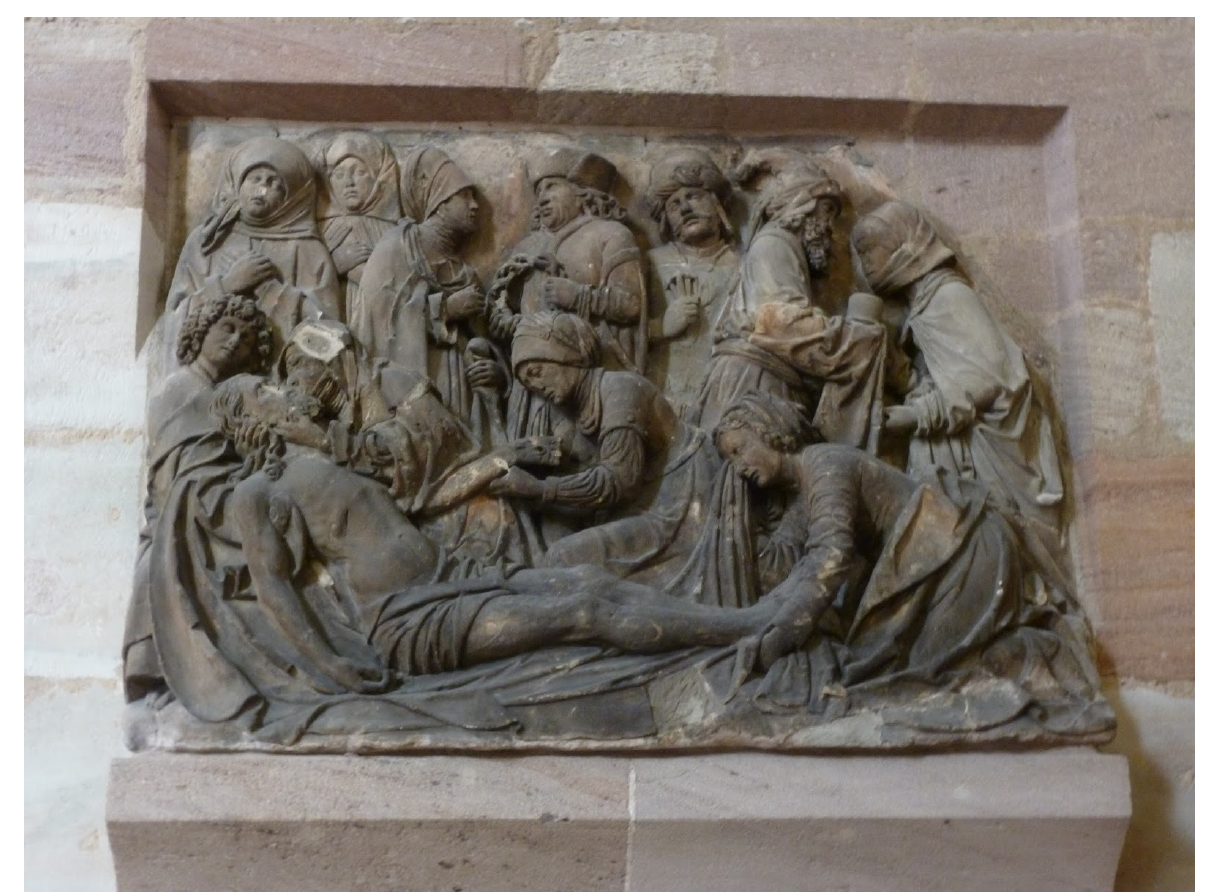
Figure 21. Kraft, Stations of the Cross, Nuremberg. Station Seven (Germanisches Nationalmuseum).